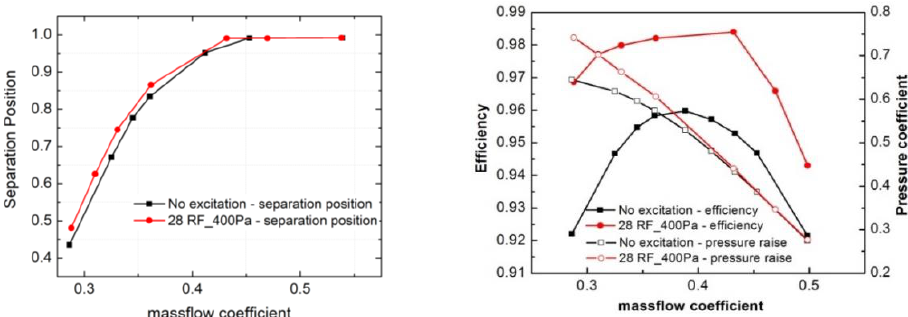
Figure 18. Variation of separation position on the suction side ( left ) and total performance ( right ) under pressure-side vortex control